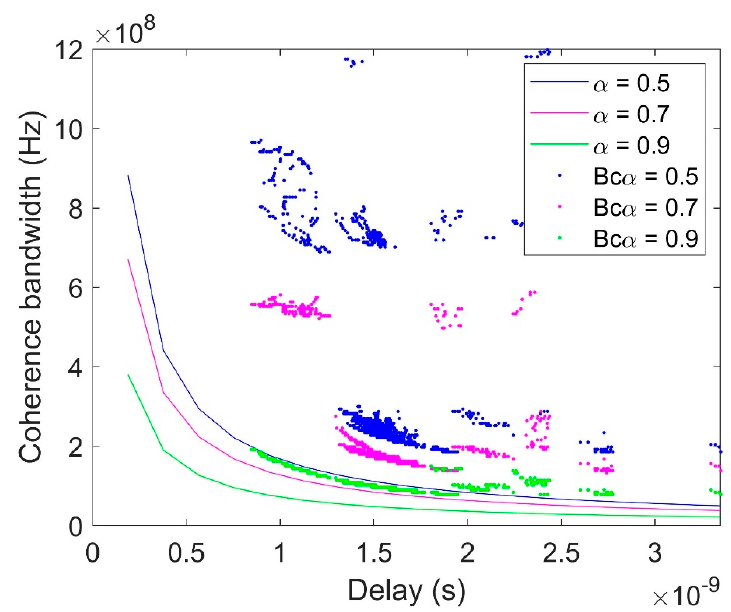
Figure 14. Theoretical Fleury limit and measured results, for different correlation levels α = 0.5, 0.7, or 0.9, at the auditorium in the 60 GHz band, received by antenna “3”.